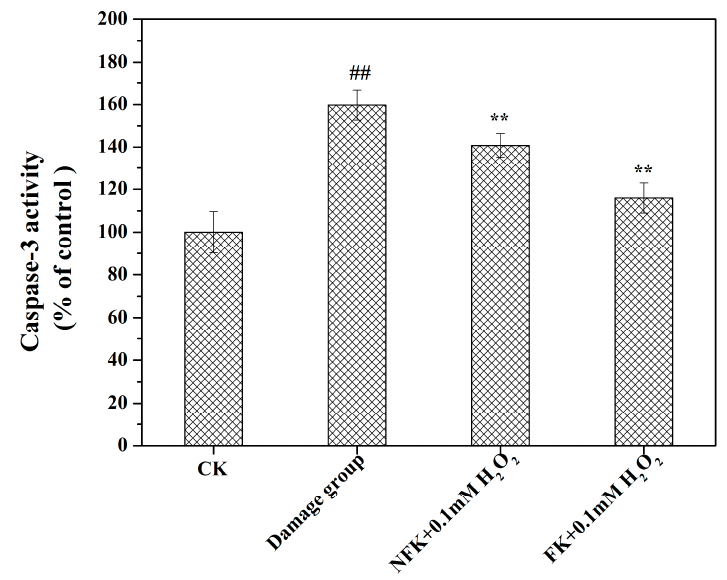
Figure 9. Effects of caspase-3 activity of NFK (10 mg/mL) and FK (10 mg/mL) on H 2 O 2 -treated PC12 cells. Data are presented as mean ± S.D., ( n = 3). ## p < 0.01 compared with the control cells; ** p < 0.01 compared with the H 2 O 2 damage group.